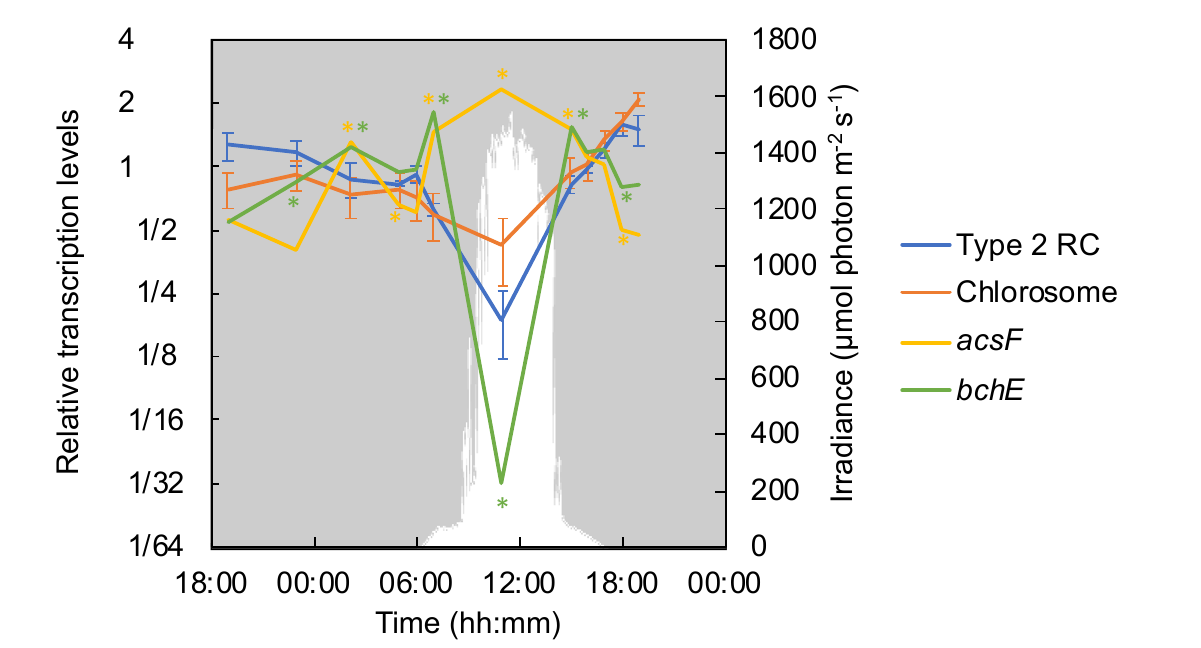
Figure 3. Relative transcription levels of genes encoding photosynthetic reaction center and chlorosome proteins, as well as genes involved in bacteriochlorophyll biosynthesis. Mean values of genes encoding the type 2 reaction center (RC) ( pufLMC : Cagg_1639–1640 and Cagg_2631) and chlorosome proteins ( csmAMNOPY : Cagg_1222, Cagg_1209, Cagg_1208, Cagg_2486, Cagg_1206, and Cagg_1296) are represented by a blue line and an orange line, respectively, with standard deviations. The values of Mg-protoporphyrin IX monomethyl ester aerobic cyclase ( acsF , Cagg_1285, yellow line) and anaerobic cyclase ( bchE, Cagg_0316, green line) are shown. The downwelling photon irradiance (photosynthetically active radiation [PAR]; 400–700 nm) is indicated in white. The asterisk indicates the transcription of a particular gene corresponding to the color in a timepoint differed significantly ( p < 0.05) from that in the previous timepoint.